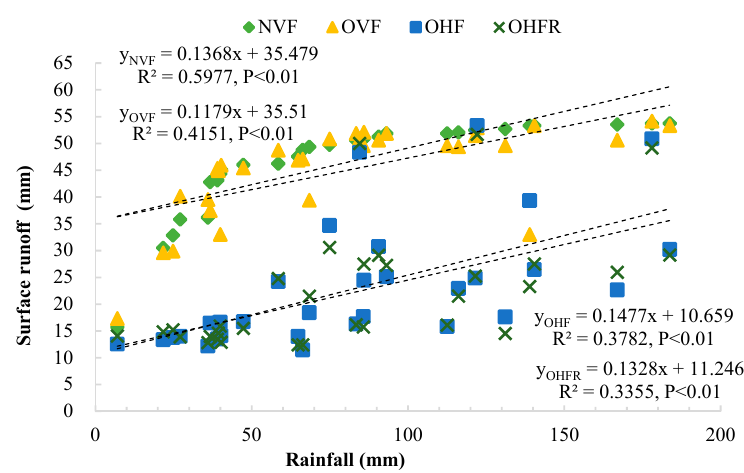
Figure 5. Linear regressions of runoff depth and rainfall under four treatments.